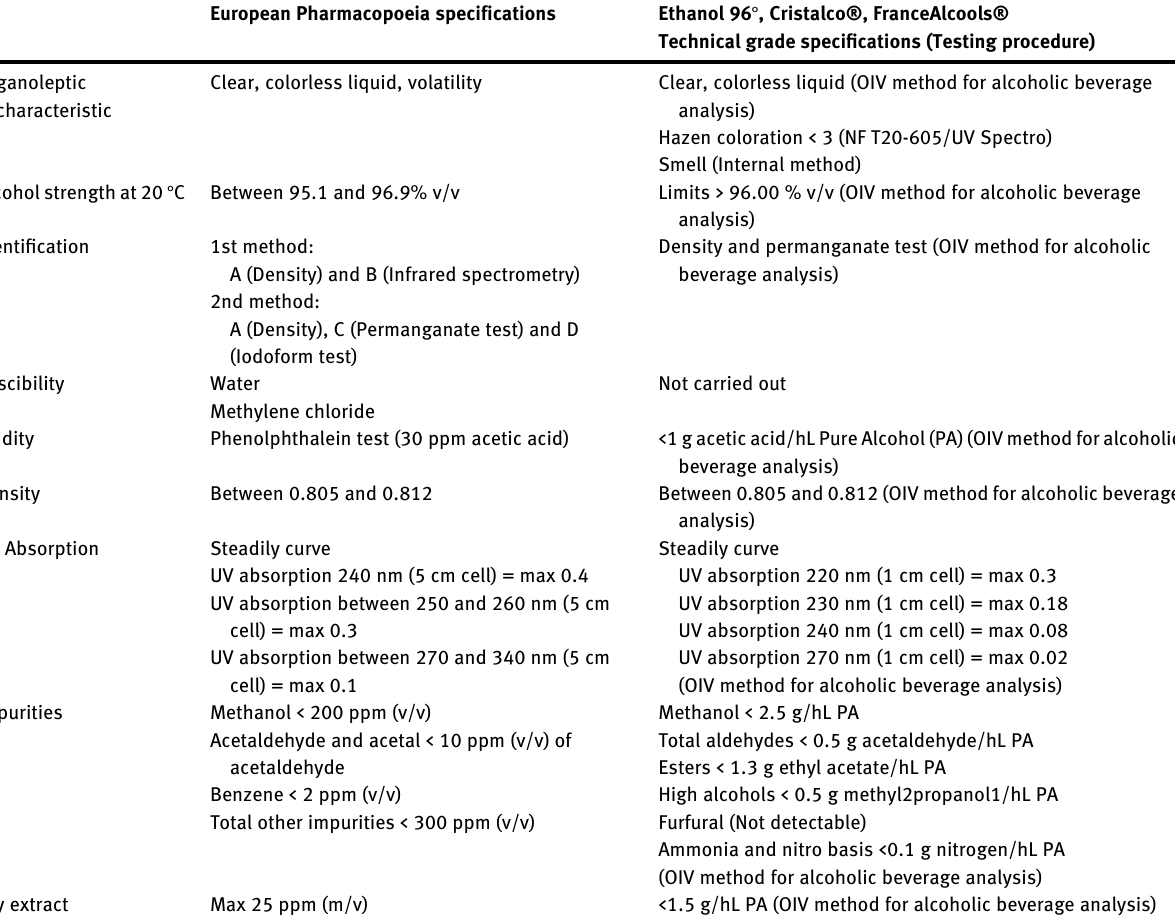
Table  : Comparison between the European Pharmacopoeia requirements and the certi fi cate of analysis of technical-grade ethanol  ° used [  , 